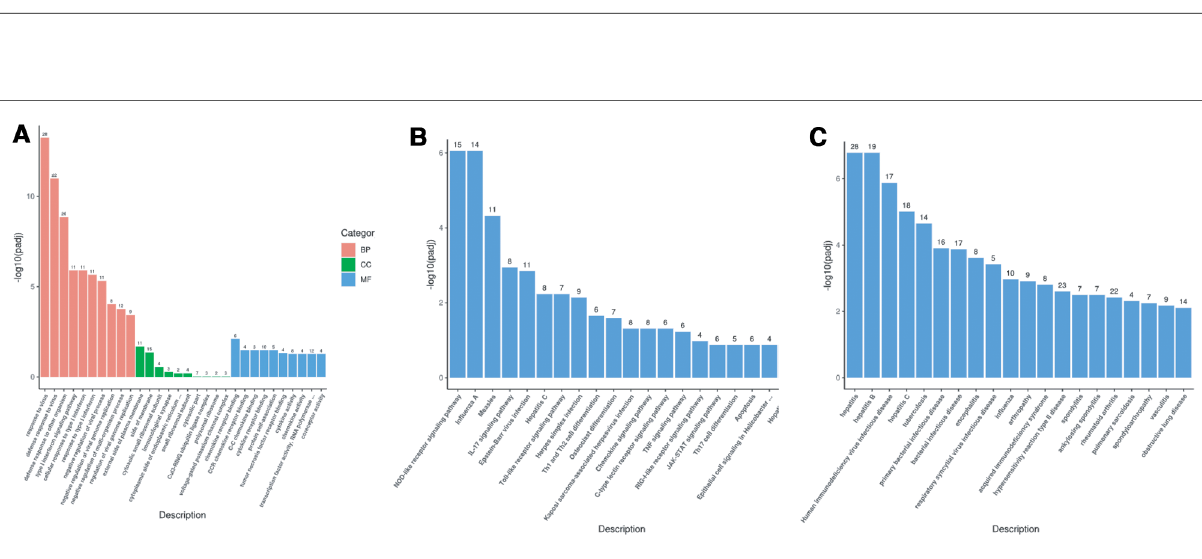
FIGURE 4 Differential gene statistical map. ( A ) Statistical histogram of the number of differential genes in different combinations. Blue and gray represent the up- regulated and down-regulated differential genes, respectively, and the numbers on the column indicate the number of differential genes. ( B ) Differential gene volcano map. In the picture, the Abscissa is present log2FoldChange, the ordinate is present -log10padj or -log10pvalue, and the blue dotted line represents the threshold line for differential gene screening criteria.